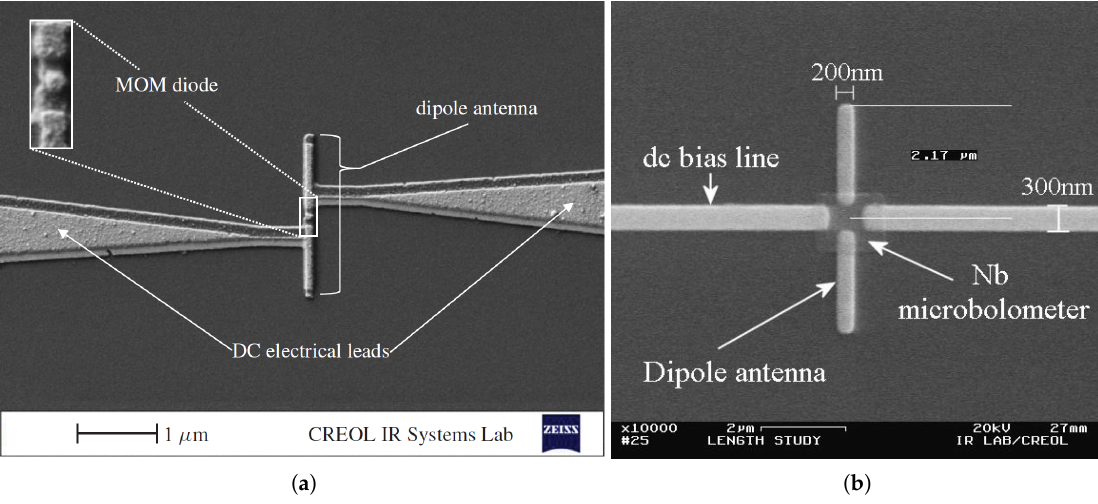
Figure 2. Scanning electron micrograph of a dipole antenna-coupled infrared detector example: ( a ) Antenna-coupled MOM diode [18], ( b ) Antenna-coupled bolometer